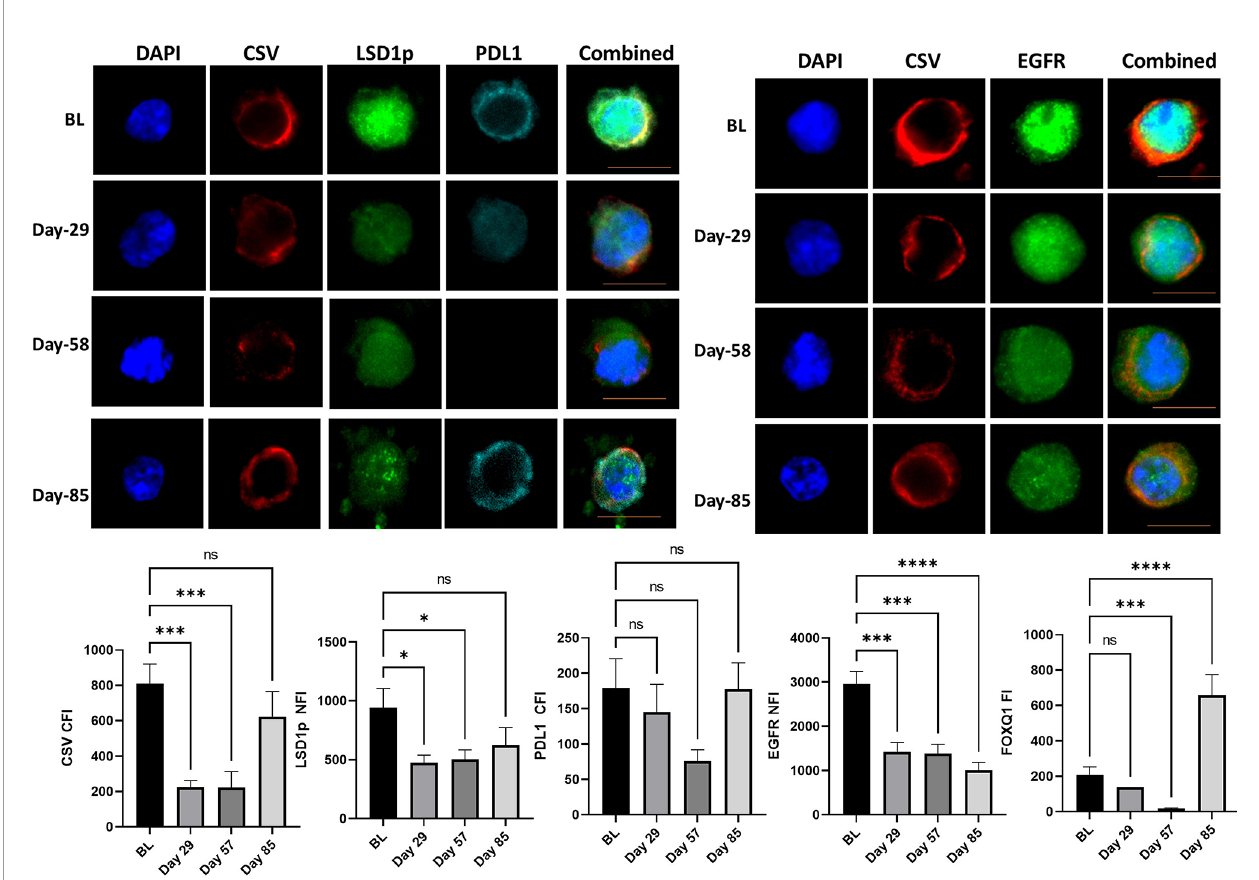
FIGURE 3 | CTC analysis of the patient with triple negative breast cancer with longest survival. The mean cytoplasmic fl uorescent intensity (CFI) or the mean nuclear fl uorescent intensity (NFI) of mesenchymal markers and PD-L1 were measured in CTC of the patients with triple negative breast cancer with longest survival was. Graphs plot the CFI or NFI mean for Cycle 1 to 3 compared to baseline readings. Signi fi cant differences were determined with a two-way ANOVA with multiple comparisons to baseline and are indicated, *<0.05, ***<0.001, ****<0.001, ns, not signi fi cant. Example images of CSV, LSD1p and PD-L1 or CSV and EGFR are shown for each time point with the scale bar in orange equal 1